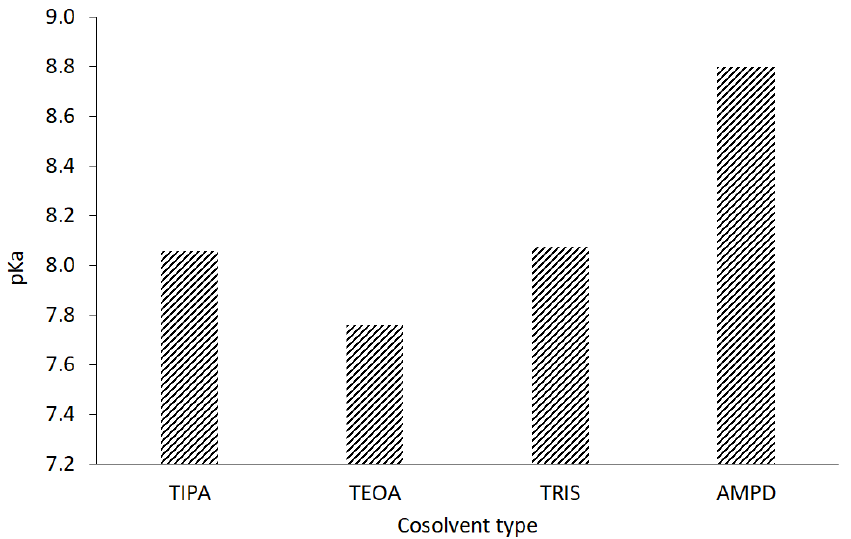
Figure 8. Acidic dissociation constants of the evaluated alcoholamines.